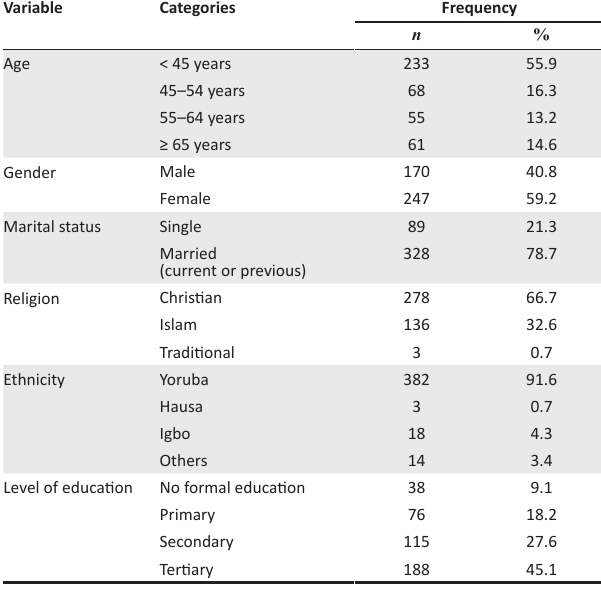
FIGURE 2: Incidences of missed prediabetes and diabetes diagnoses amongst TABLE 1: Socio-demographic characteristics of the respondents.